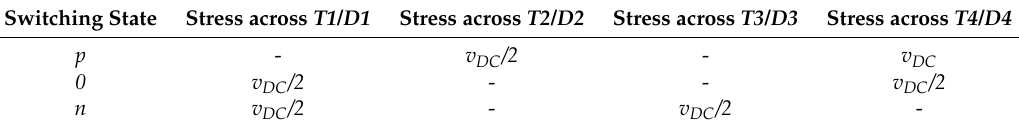
Table 2. Voltage stress across the switches for the 3L-ASYM topology at different switching states.